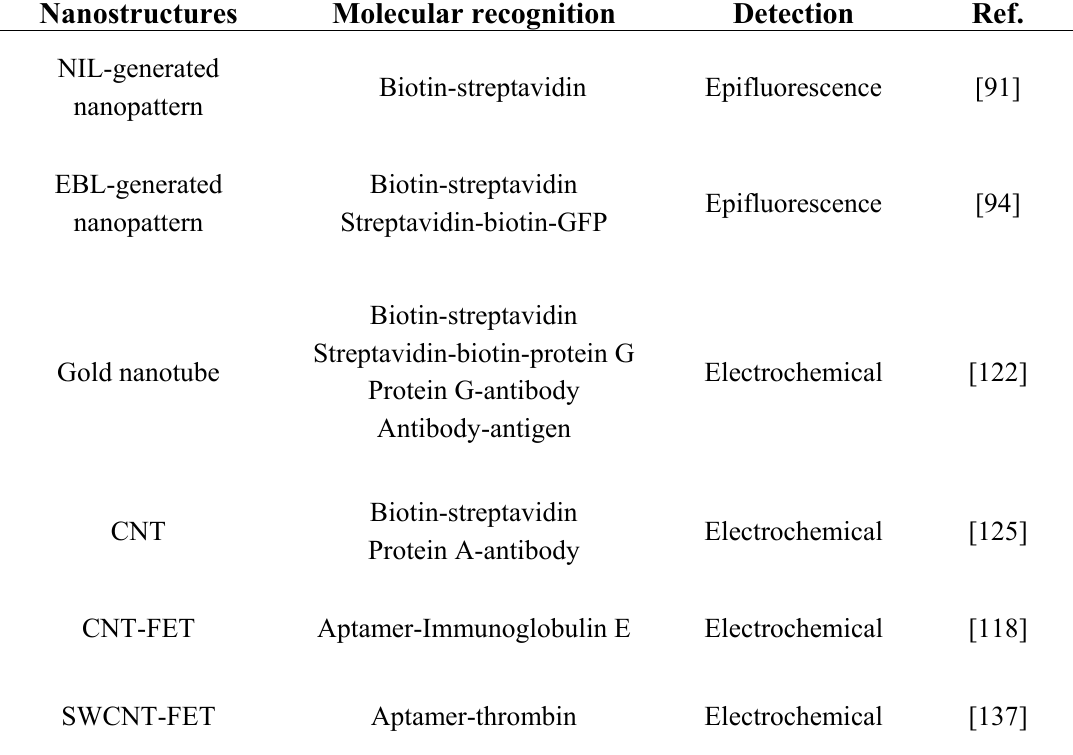
Table 7. Detection of specific molecular recognitions at the nanoscale.